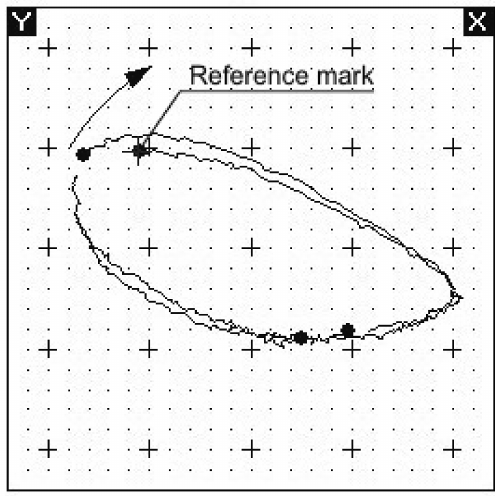
Fig. 14. Journal orbits measured on bearing #2 during an event of abnormal vibrations of the HP-IP